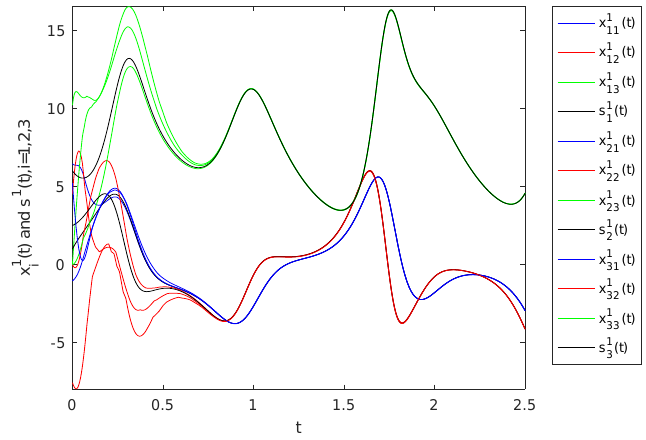
( 1 ) ( t ) and s ( 1 ) ( t ) under Controller (17). ı